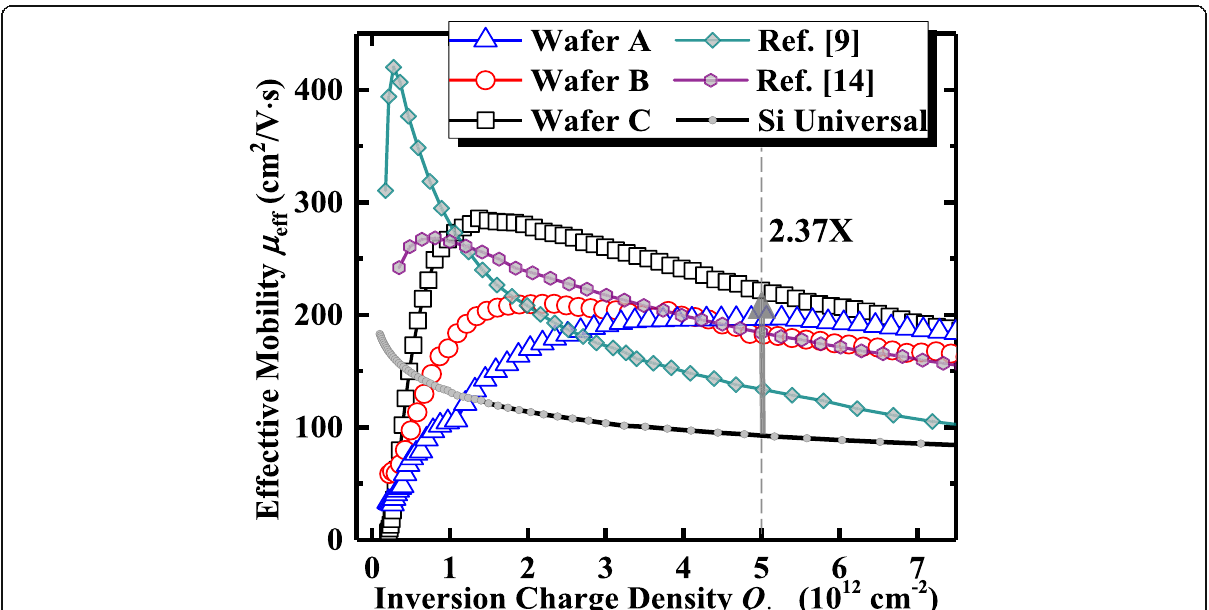
Fig. 8 μ eff versus Q inv of Ge pMOSFETs with different passivation conditions. Ge transistors with 15 cycles Al 2 O 3 + 20 min O 3 oxidation (wafer C) exhibit a peak μ eff of 283 cm 2 /Vs. The impact of S/D resistance on μ eff extraction was removed by the total resistance slope-based effective channel mobility extraction method [16]